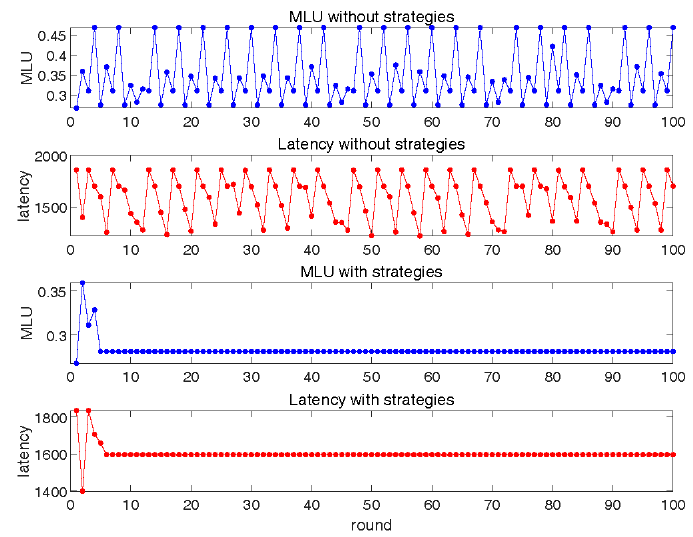
Figure 9. Interaction between SRC with data plane fault correction and LLS.